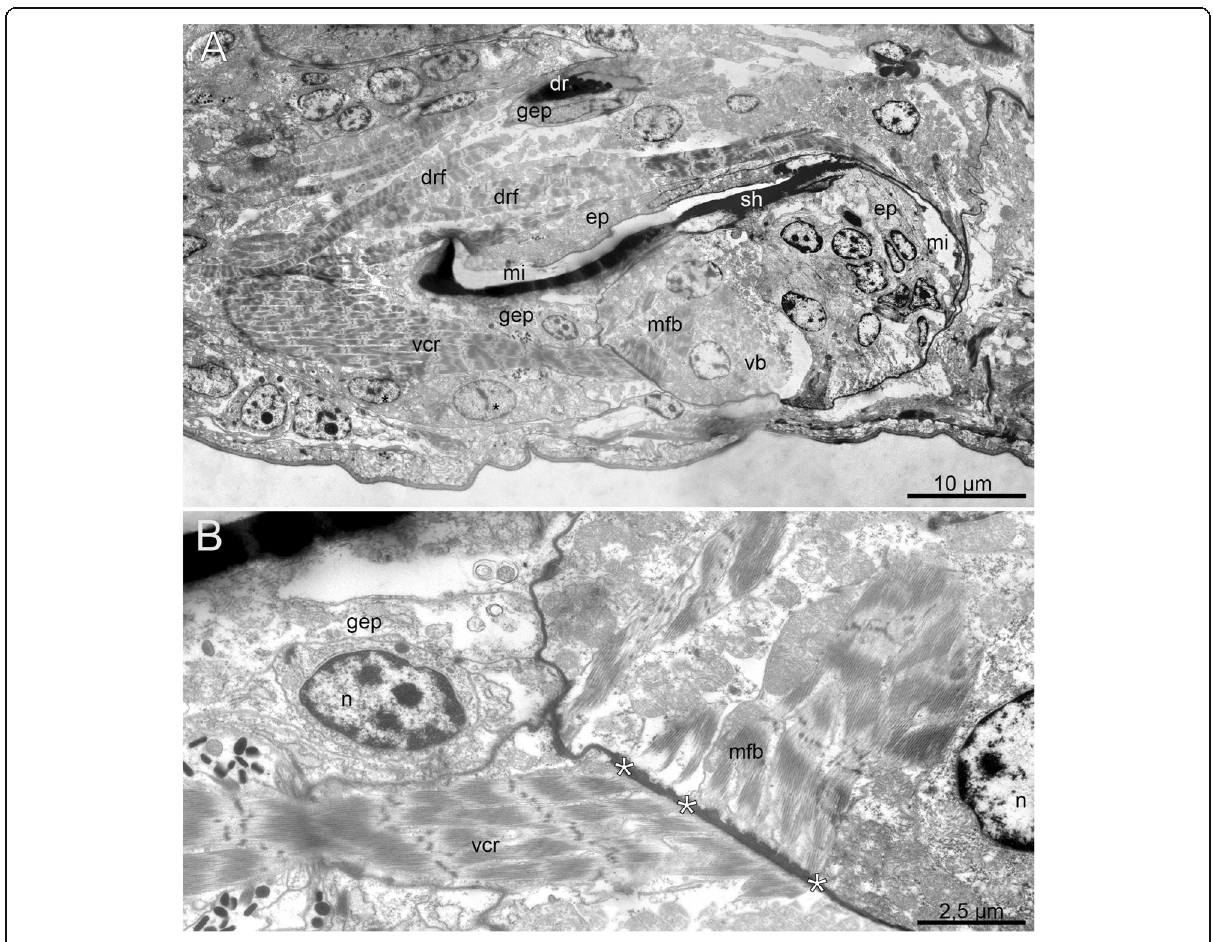
Fig. 5 Fine structure of the ventral pharyngeal organ (VPO) and jaws of Histriobdella homari . Parasagittal section, TEM images. a. General overview of the VPO. Black asterisks mark nuclei of the gnathoepithelial cells. b. С ontact zone between muscle fibers of the ventral bulb and the ventral carrier retractor. White asterisks mark the zone with dense hemidesmosomes. dr, dorsal rod; drf, dorsal rod flexor; ep, epithelium of the median VPO invagination; gep, gnathoepithelial cell; mfb, muscle cell of the ventral bulb; mi, median VPO invagination; n, nucleus; sh, mandibular shaft; vb, ventral muscle bulb; vcr, ventral carrier